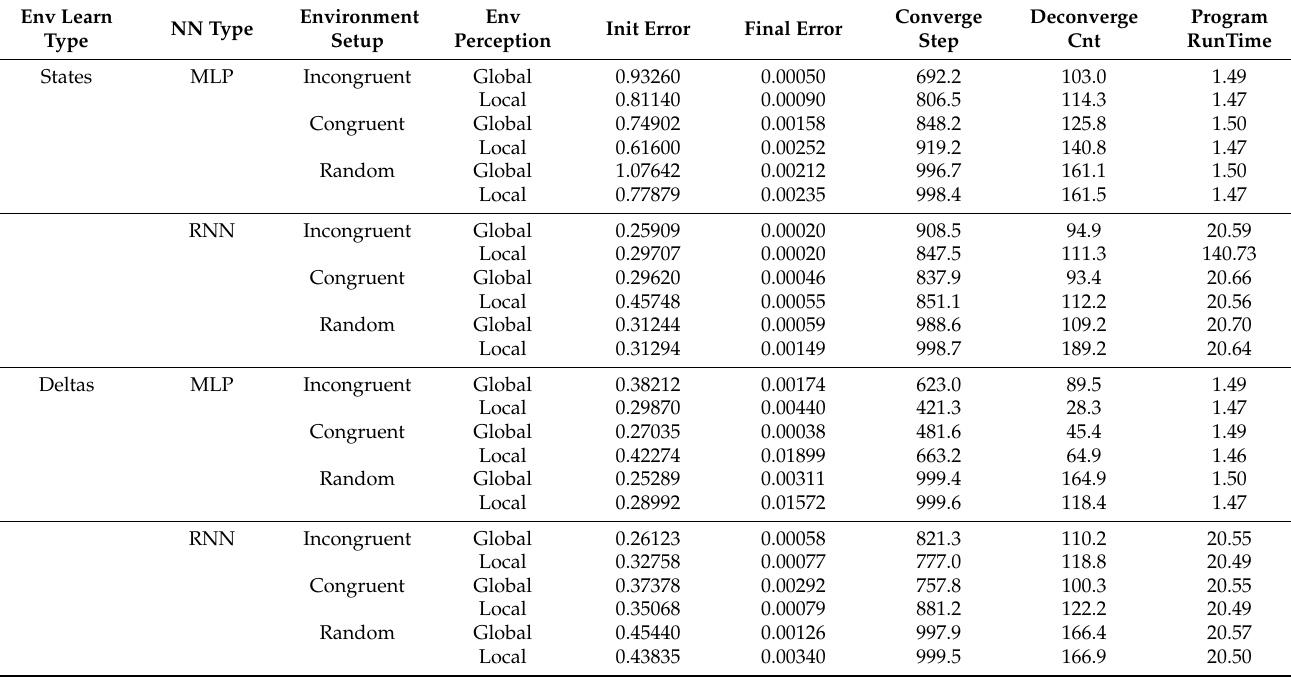
Table 2. Main Results (Max Pos Goal